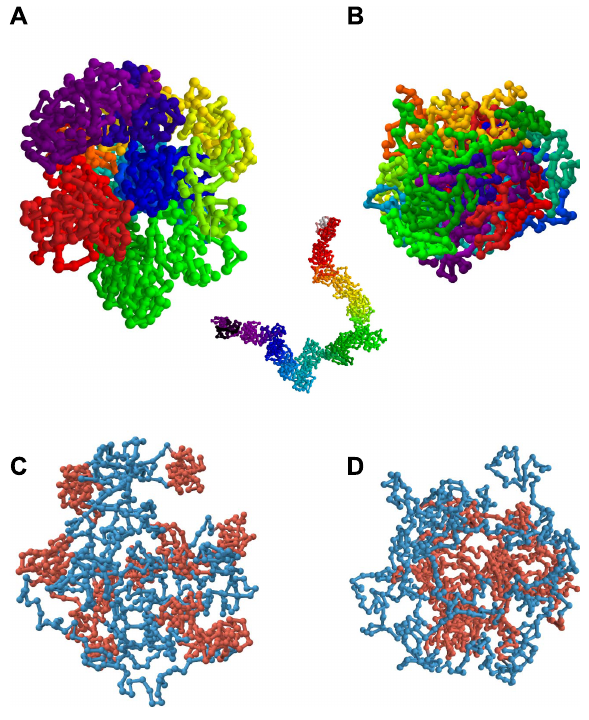
Figure 3. Example of polymer conformations of the adapted DL model at different looping regimes. ( A ) Conformation of the adapted-DL polymer with high short-range (p short =0.12) and low long- range (p long =0.04) looping probabilities and ( B ) the same polymer with low short-range (p short =0.04) and high long-range (p long =0.12) looping probabilities. The colour code labels the monomers of the polymer according to the visible spectrum along the length of the polymer. The inset in panel A displays the same situation as in (A) after abolishing all long-range looping (p long =0), showing that a uniform thick fibre is formed. More adapted DL polymer conformations with the same looping probabilities as shown in (A) and (B) are shown in Figure S5. ( C ) Conformation of the domain-adapted DL polymer with high short- range (p short =0.16) and low long-range (p long =0.02) looping probabil- ities and ( D ) the same polymer with low short-range (p short =0.02) and high long-range (p long =0.16) looping probabilities. Here, topological domains are labelled red and non-looping linker regions